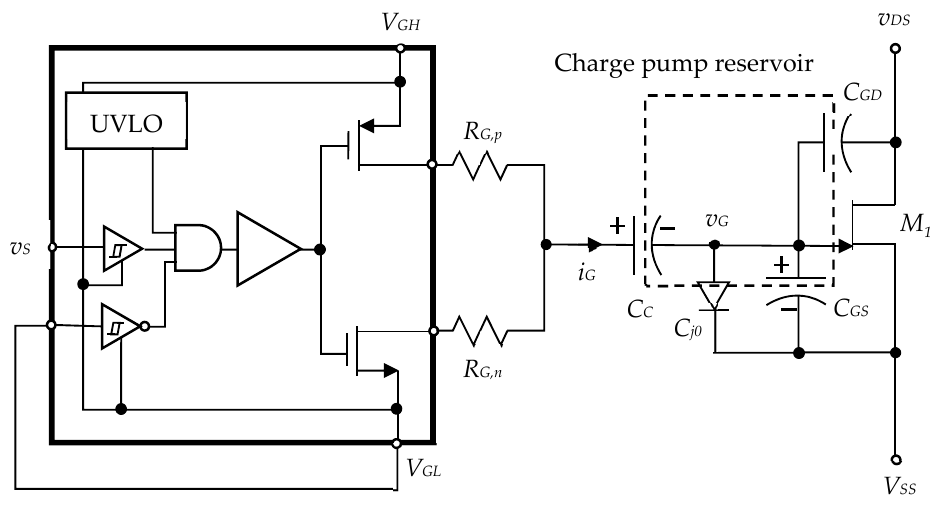
Figure 3. Gate drive design.